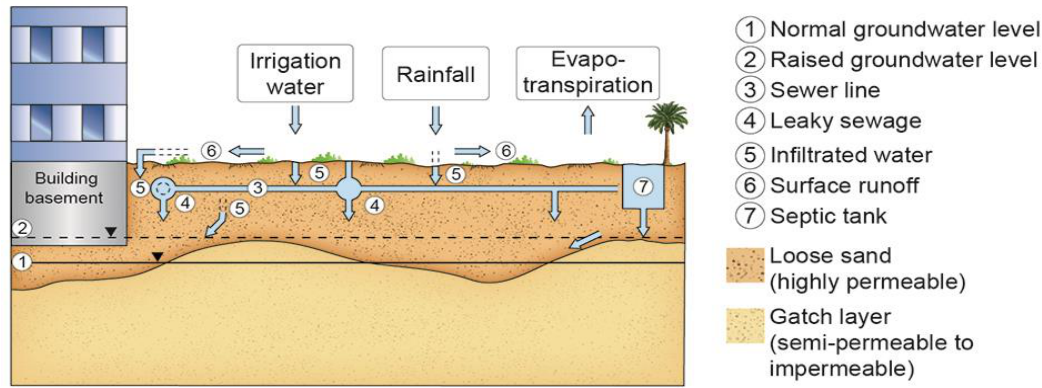
Figure 3. Schematic illustration for the problem of shallow water table development in Kuwait City.